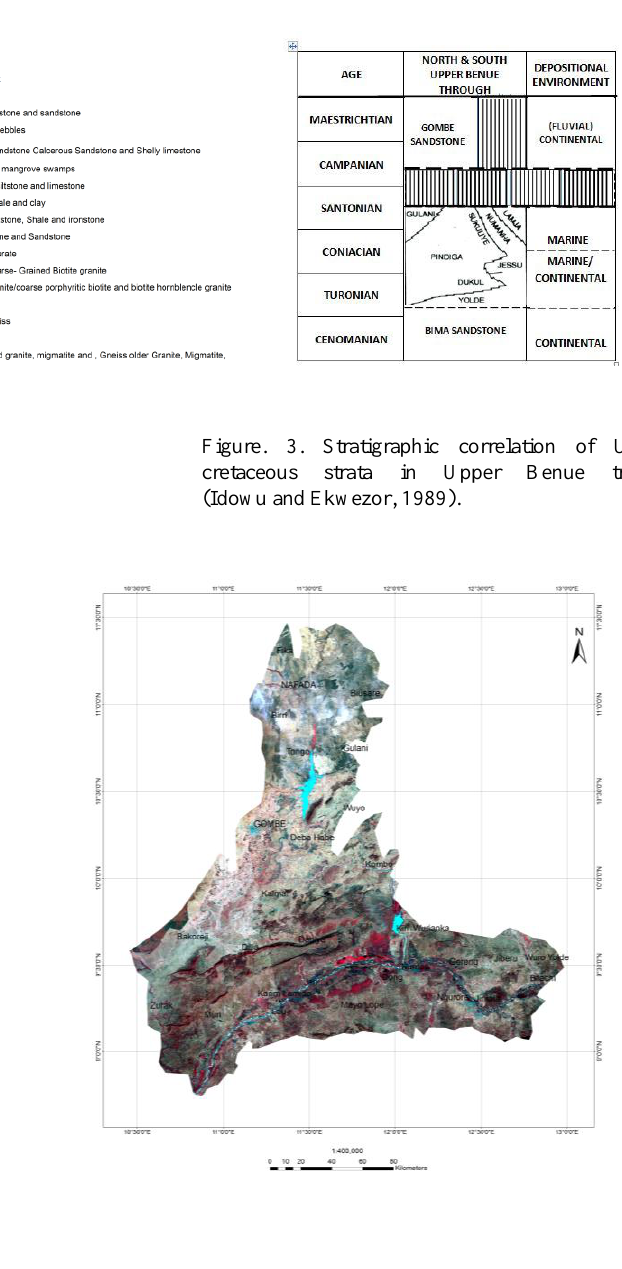
Figure 5. NigeriaSat-X image of the Upper Benue Trough